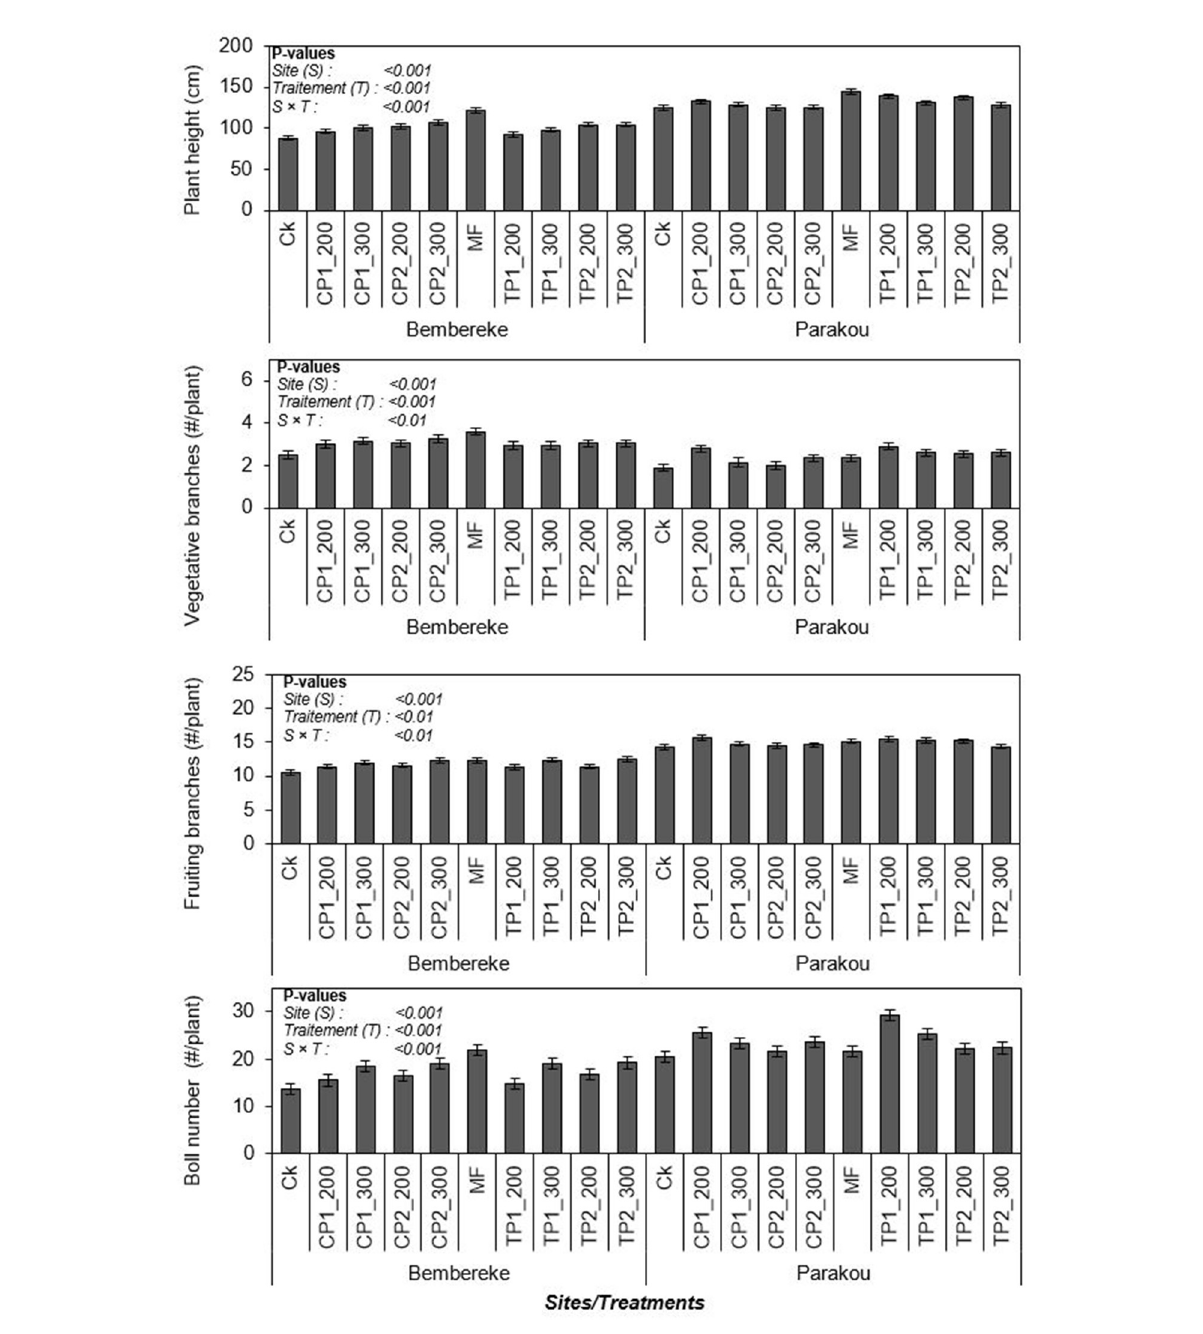
FIGURE3 Site by treatment interaction effect on plant height, number of vegetative and fruiting branches, and number of bolls of cotton. Ck, control; MF, mineral fertilizer; CP1-200, Compost of Banikoara at 200 kg/ha; CP1-300, Compost of Banikoara at 300 kg/ha; CP2-200, Compost of Toffo at 200 kg/ha; CP2-300, Compost of Toffo at 300 kg/ha; TP1_200, Terra preta of Banikoara at 200 kg/ha; TP1_300, Terra preta of Banikoara at 300 kg/ha; TP2_200, Terra preta of Toffo at 200 kg/ha; TP2_300, Terra preta of Toffo at 300 kg/ha.